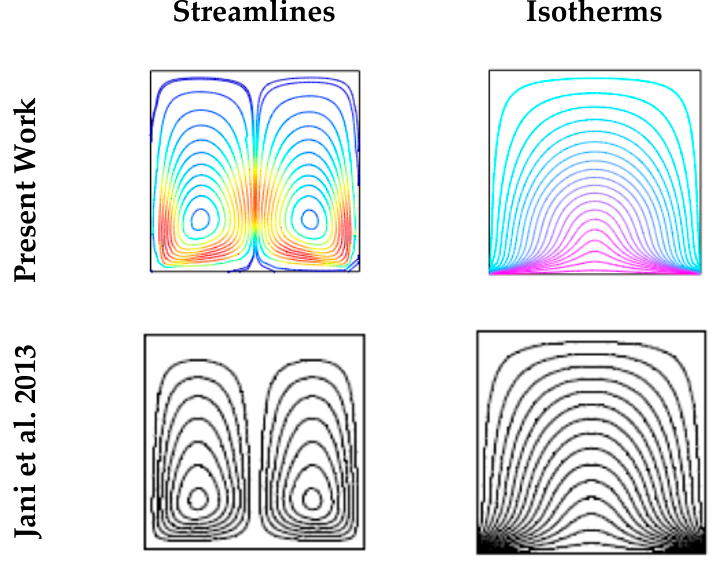
Figure 2. Comparison of streamlines and isotherms of by Jani et al. [10] and the present work with Pr = 0.71, Ha = 50 and Ra = 10 5 .